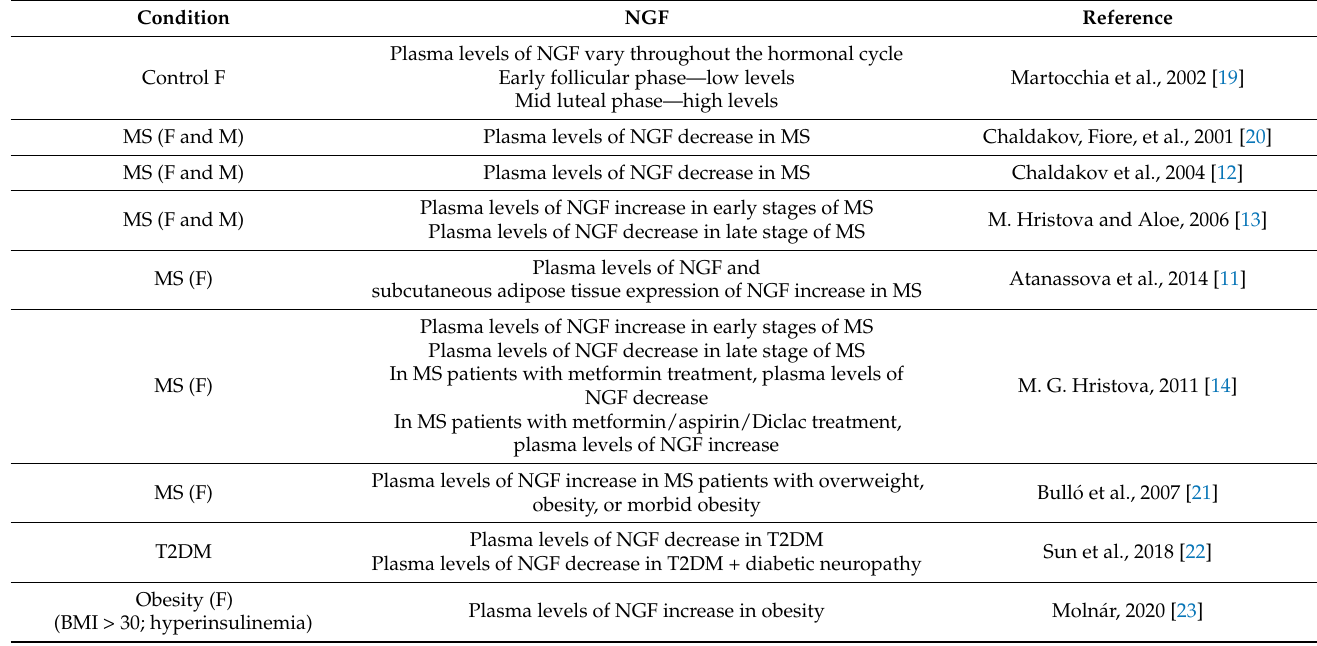
Table 1. Metabolic syndrome is associated with alterations in NGF